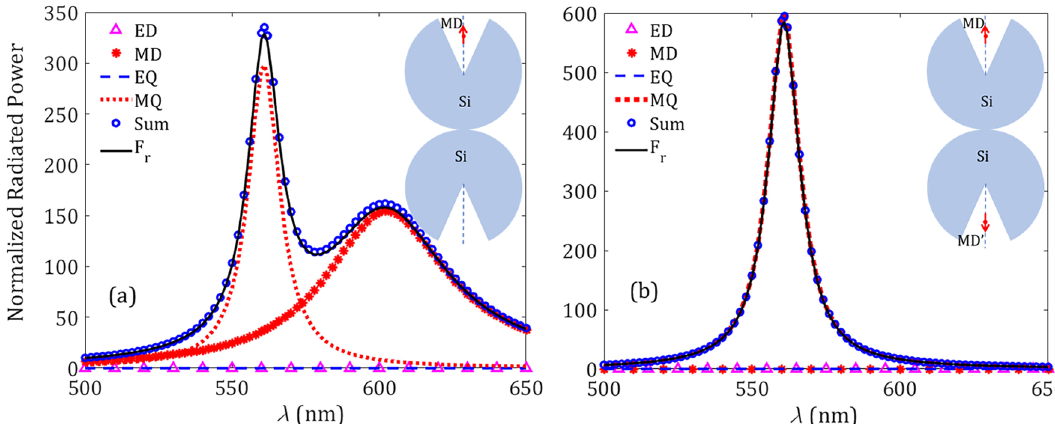
Figure 9. Modal radiative power, corresponding to the lowest-order modes. The resonator and its mirror image excited by ( a ) a single MD emitter, and ( b ) a MD emitter and its mirror image MD ′ . All the geometrical parameters are the same as Fig. 8. Note that radiated power is normalized to free-space radiation power ( a ) P 0 and ( b ) 2 P 0 . The latter normalization in ( b ) is equivalent to evaluate the ratio of the radiated power by a single emitter in the half space above the PEC and the total radiated power P 0 in free